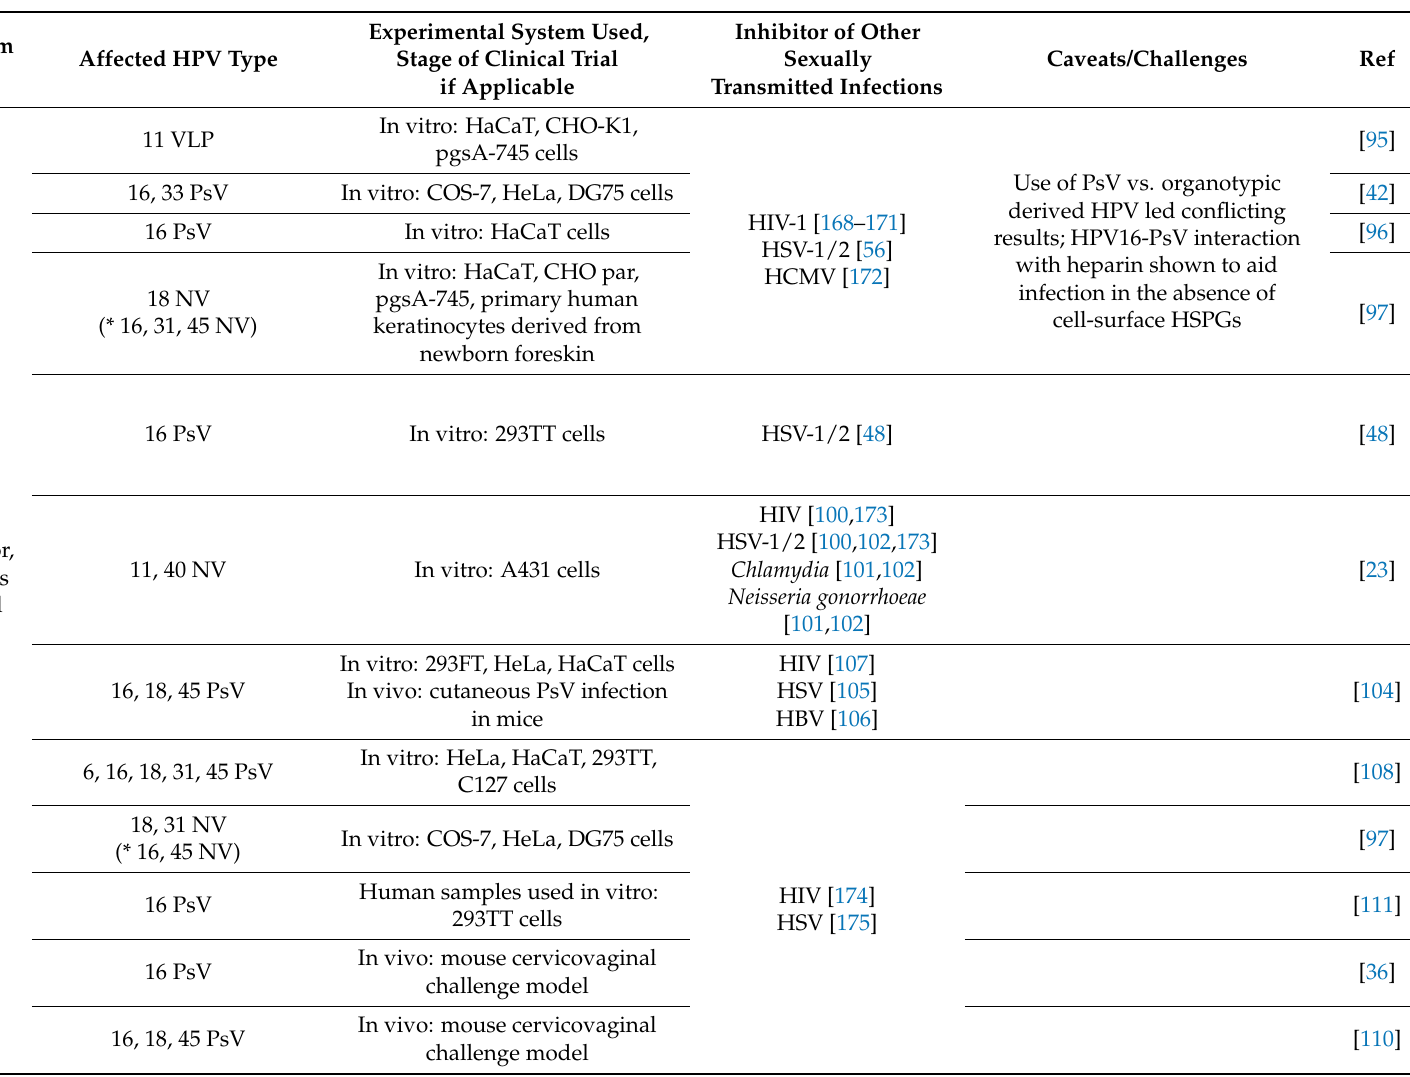
Table 1. Summary of potential inhibitory molecules that target the early steps of HPV